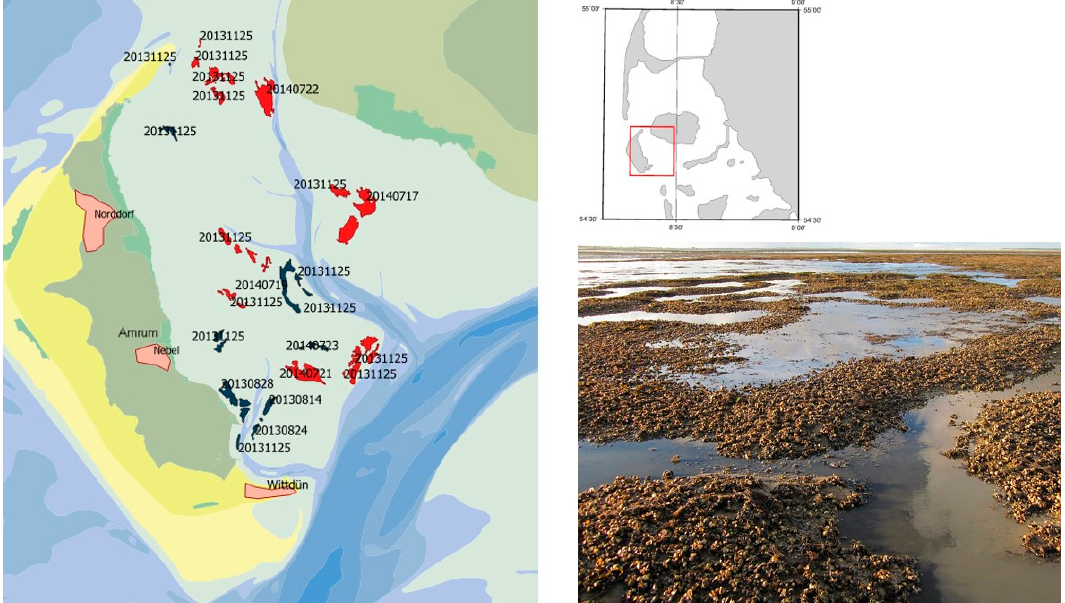
Figure 3. ( Left ): results from field campaigns carried out in 2013 and 2014. The labelled patches denote bivalve beds of blue mussels (blue) and oysters (red); ( upper right ): map showing the map location as red rectangle; ( lower right ): photograph (J. Kohlus) of bivalve beds showing the typical patchy distribution of elevated bivalves, water puddles, and sediments.